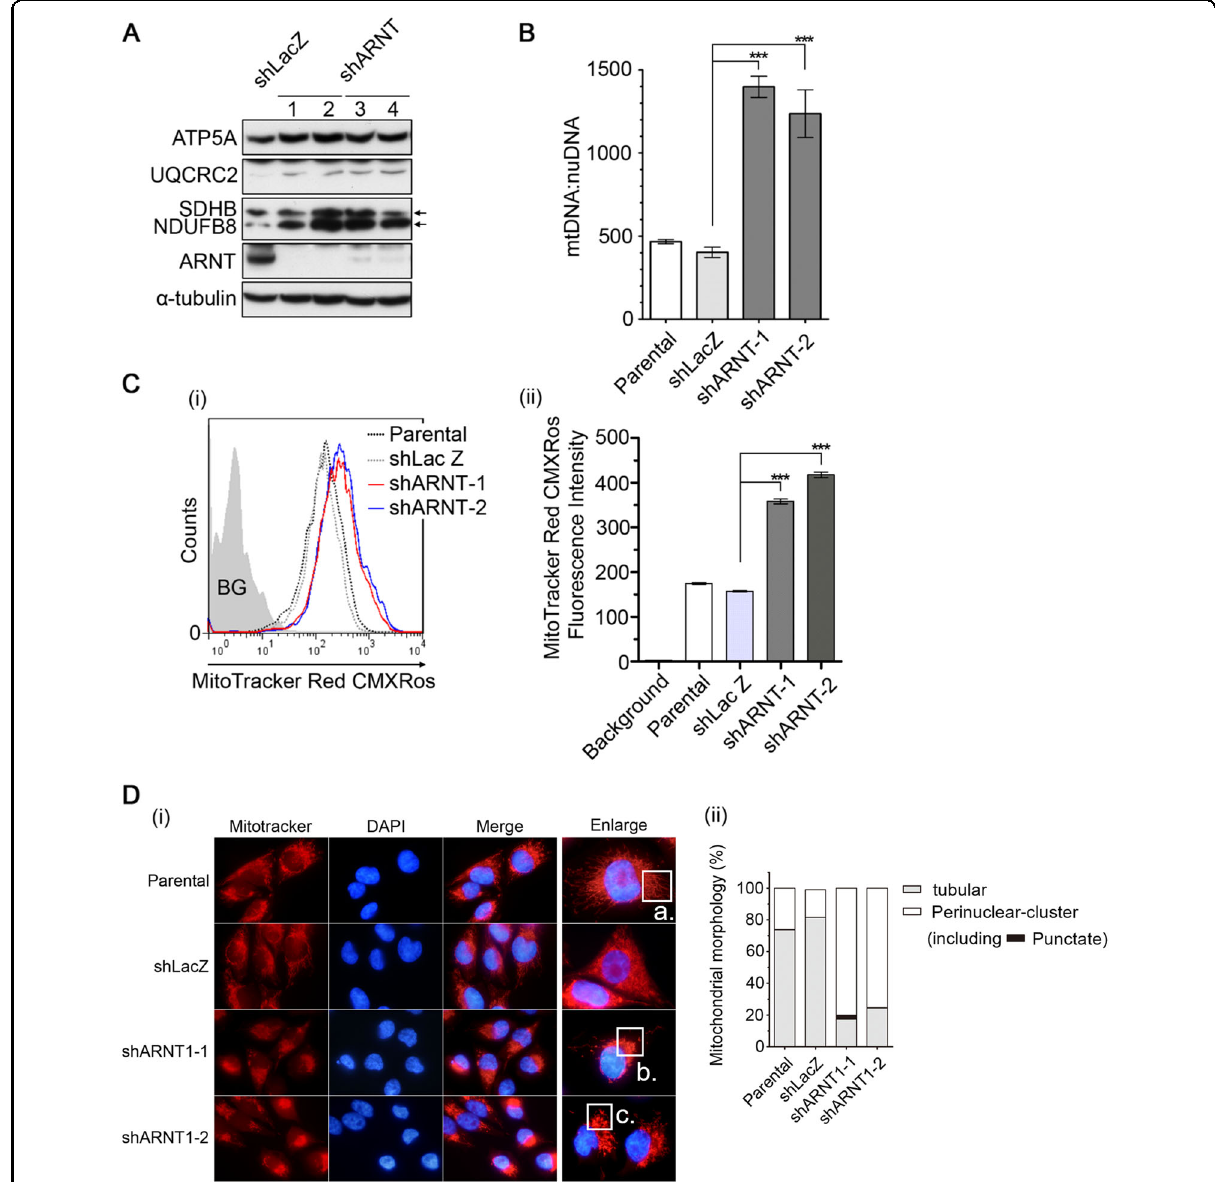
Fig. 2 ARNT de fi ciency induces mitochondrial activity. A A375 cell lysates were prepared and subjected to SDS-PAGE and then analyzed by Western blotting with antibodies against ATP5A, UQCRC2, SDHB, NDUFB8, ARNT, and α -tubulin. B Mitochondrial DNA (mtDNA) and nuclear DNA (nuDNA) were measured by quantitative PCR from total genomic DNA extracted from cells. The copy number of mitochondrial DNA was normalized by nuclear DNA. C Mitochondrial membrane potential was quanti fi ed using Mitotracker Red CMXRos staining in shARNT A375 cells. After 30 min incubation with Mitotracker Red CMXRos, cells were harvested and analyzed by fl ow-cytometry (i). The fl uorescence intensity of Mitotracker Red CMXRos from individual cell was statistically analyzed by Prism 6.0 software (ii). D Cells were fi xed using 4% paraformaldehyde after incubated with Mitotracker Red CMXRos for 30 min. Immuno fl uorescence images were acquired using a microscope (i). The cell number with tubular, perinuclear and punctate morphology of the mitochondria was counted and statistically analyzed by using more than 100 cells with Prism 6.0 software (ii). a. tubular morphology; b. perinuclear morphology; c. punctate